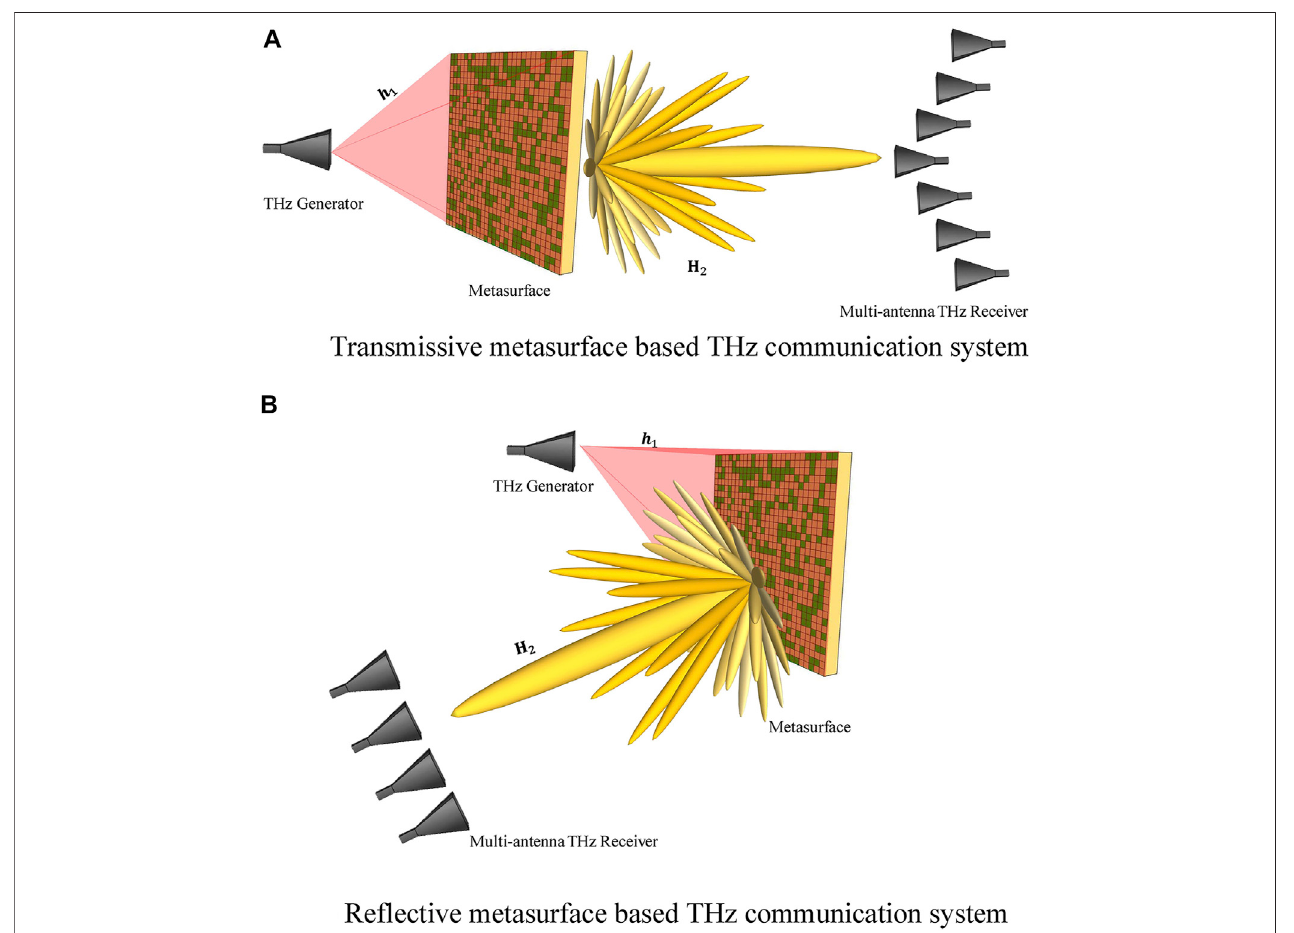
FIGURE 1 | (A) Transmissive metasurface – based THz communication system. (B) Re fl ective metasurface – based THz communication system.